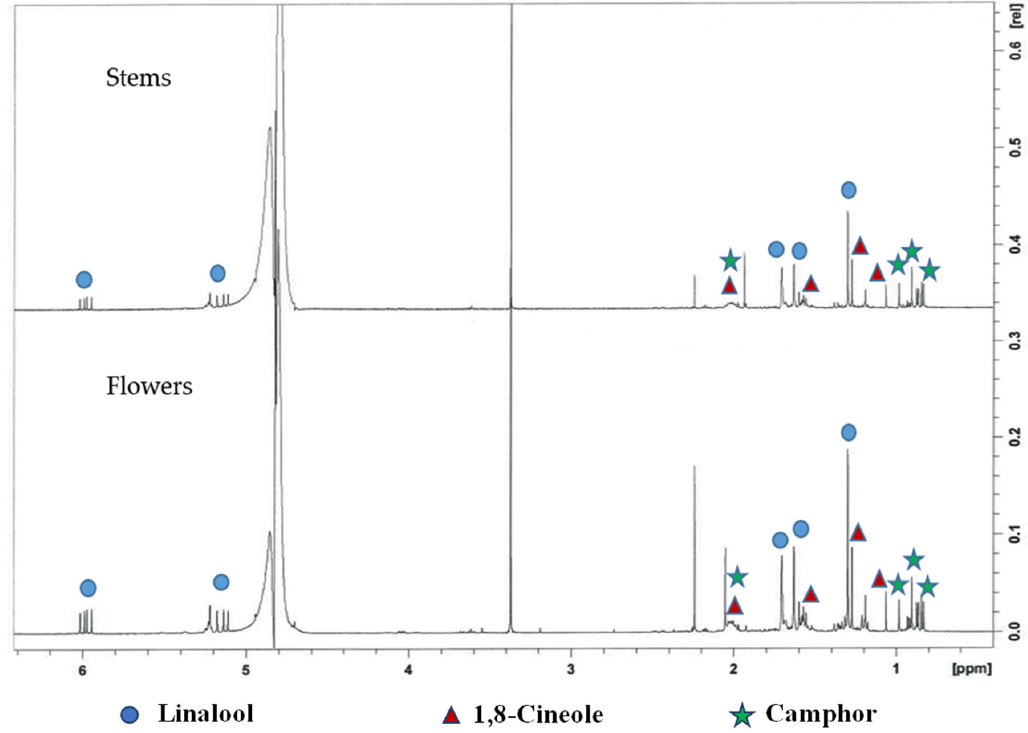
Figure 1. 1 H NMR spectra of Lavandin flowers and stems aromatic waters.